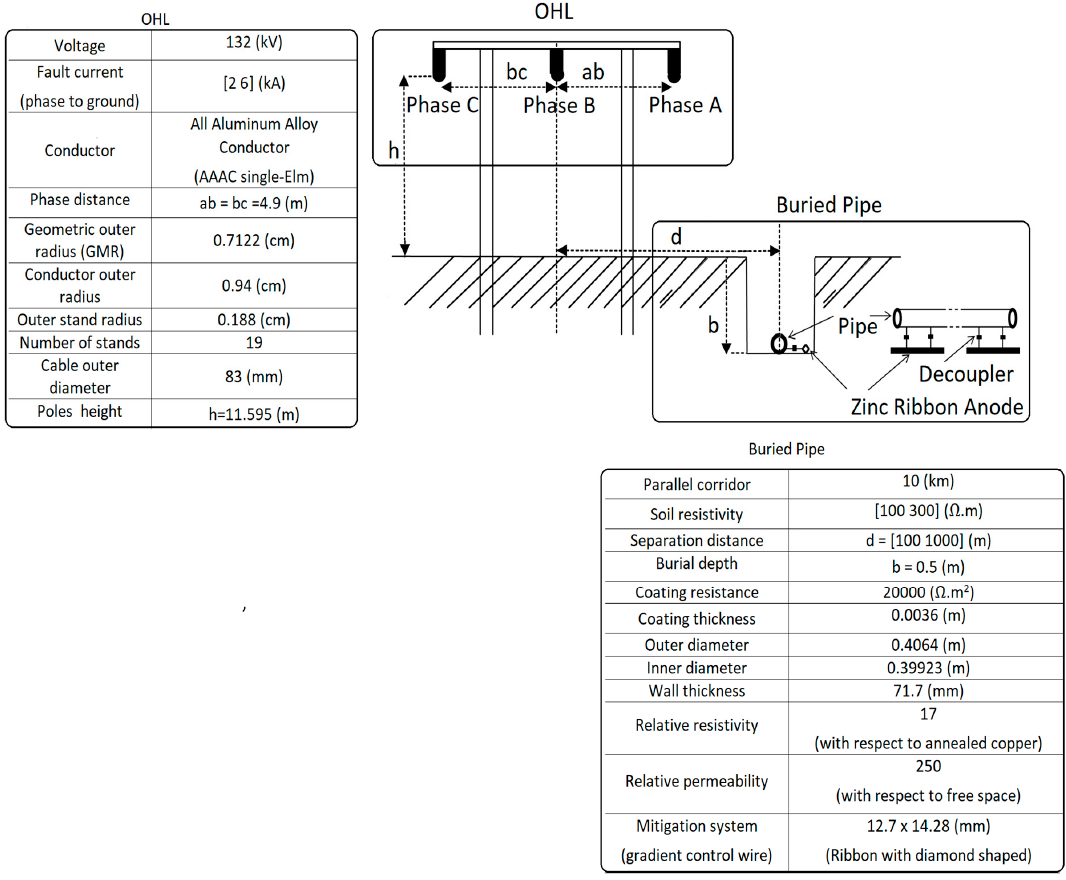
Figure 2. Cross section of 132-kV overhead lines (OHL) and the buried pipeline with a mitigation system.